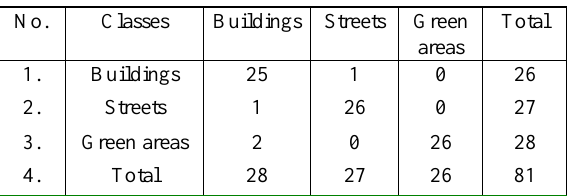
Table 2 . Matrix for the image from 2017